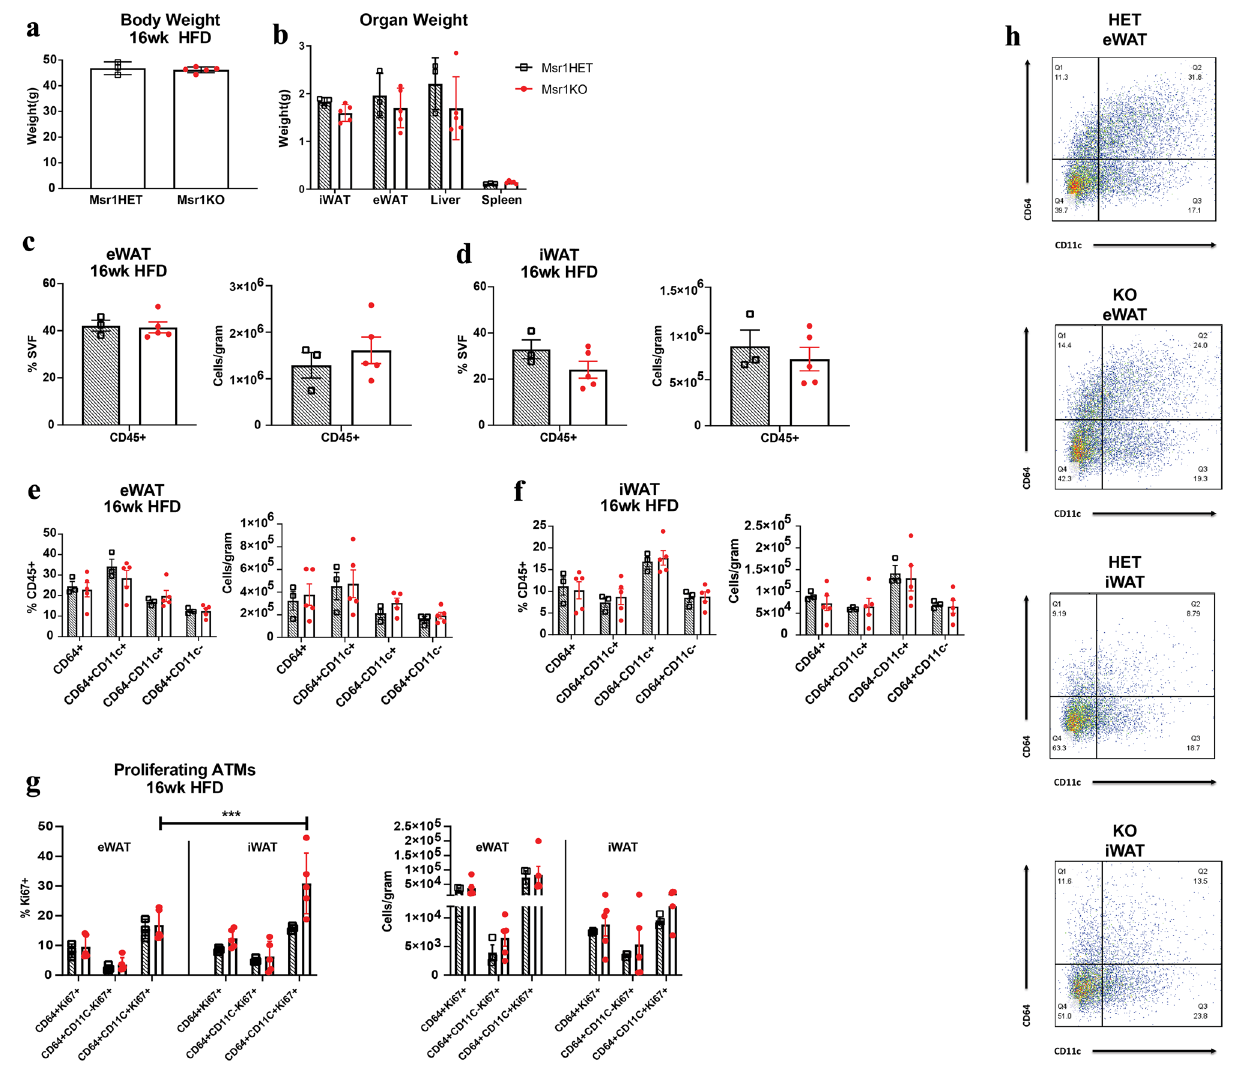
Figure 4. Msr1 is not required for ATM infiltration during obesity in obese male mice. ( a ) Whole body weight and ( b ) organ weight for 16-week male HFD-fed Msr1HET (black) and Msr1KO (red) mice. Flow cytometry analysis of CD45 + cells in the SVF ( c , d ); ATM subtypes ( e – f ); and proliferating ATMs ( g ) in eWAT and iWAT. ( h ) Representative flow cytometry graphs. n = 3–5/group. *** p = 0.0005. Statistical Analysis = 2-way ANOVA multiple